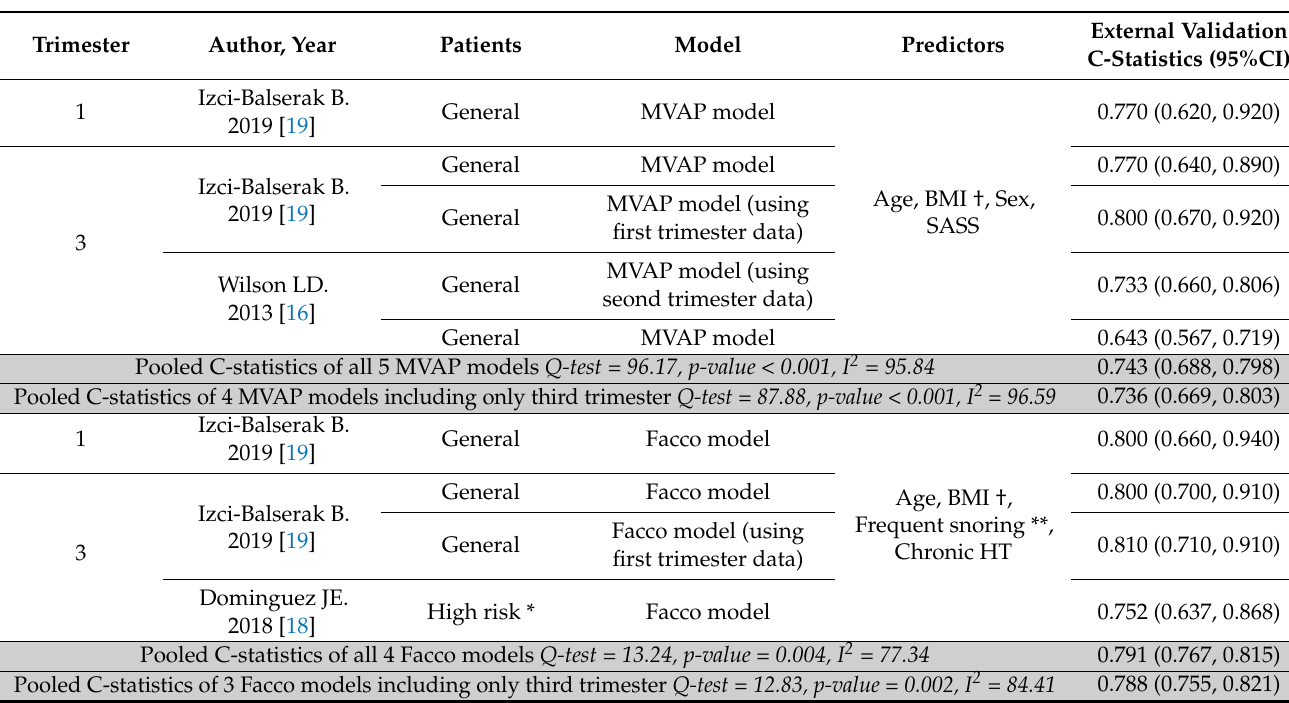
Table 5. Description and meta-analyses of discriminative model performances for external validation of MVAP and Facco models on gestational obstructive sleep